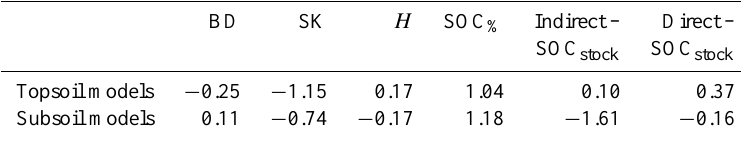
Table 6. Skewness coefficients for the residuals of each